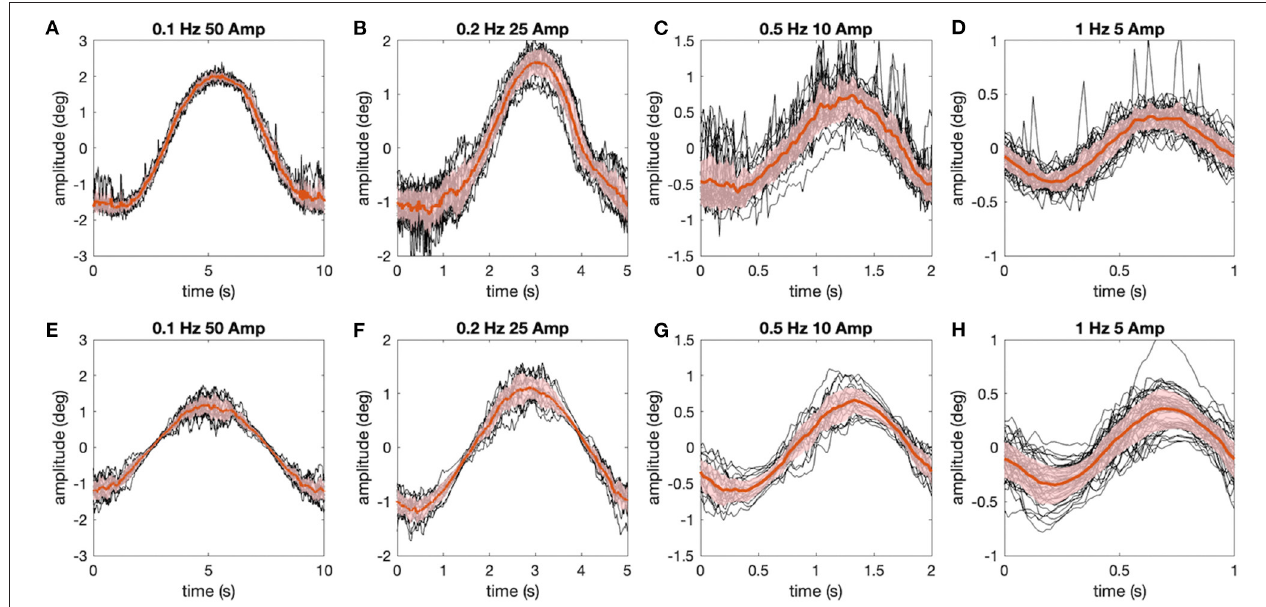
FIGURE 5 | Comparison of experimentally measured and simulated eye movements. (A–H) Eye movements (raw traces in black, red lines show average) shown for all stimulus motion cycles at different stimulus frequencies depicted for the representative animal in Figure 4 (A–D) , along with corresponding simulations (E–H) of the data using the aVOR model (with appropriately adapted parameters) and optimal gain values to minimize the retinal image slip caused by signal-dependent sensor and motor noise (see also Figure 4 ); shaded areas indicate one standard deviation of the mean response.